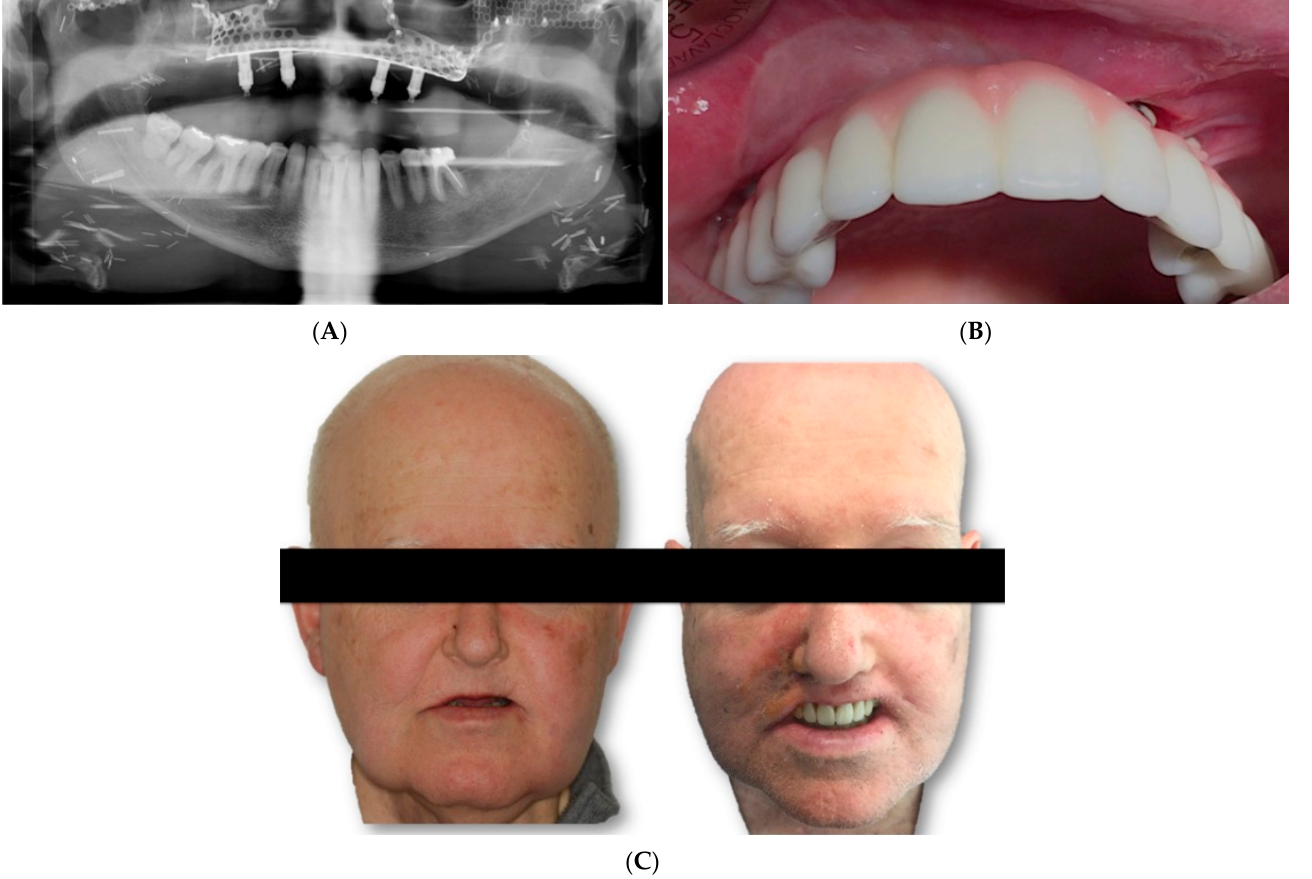
Figure 7. 3D reconstruction of the residual bone of the fibula flaps. ( A ) Ortopantomography showing the subperiostal implant. ( B ) Definitive prostheses. ( C ) Before and after of the definitive prosthesis.